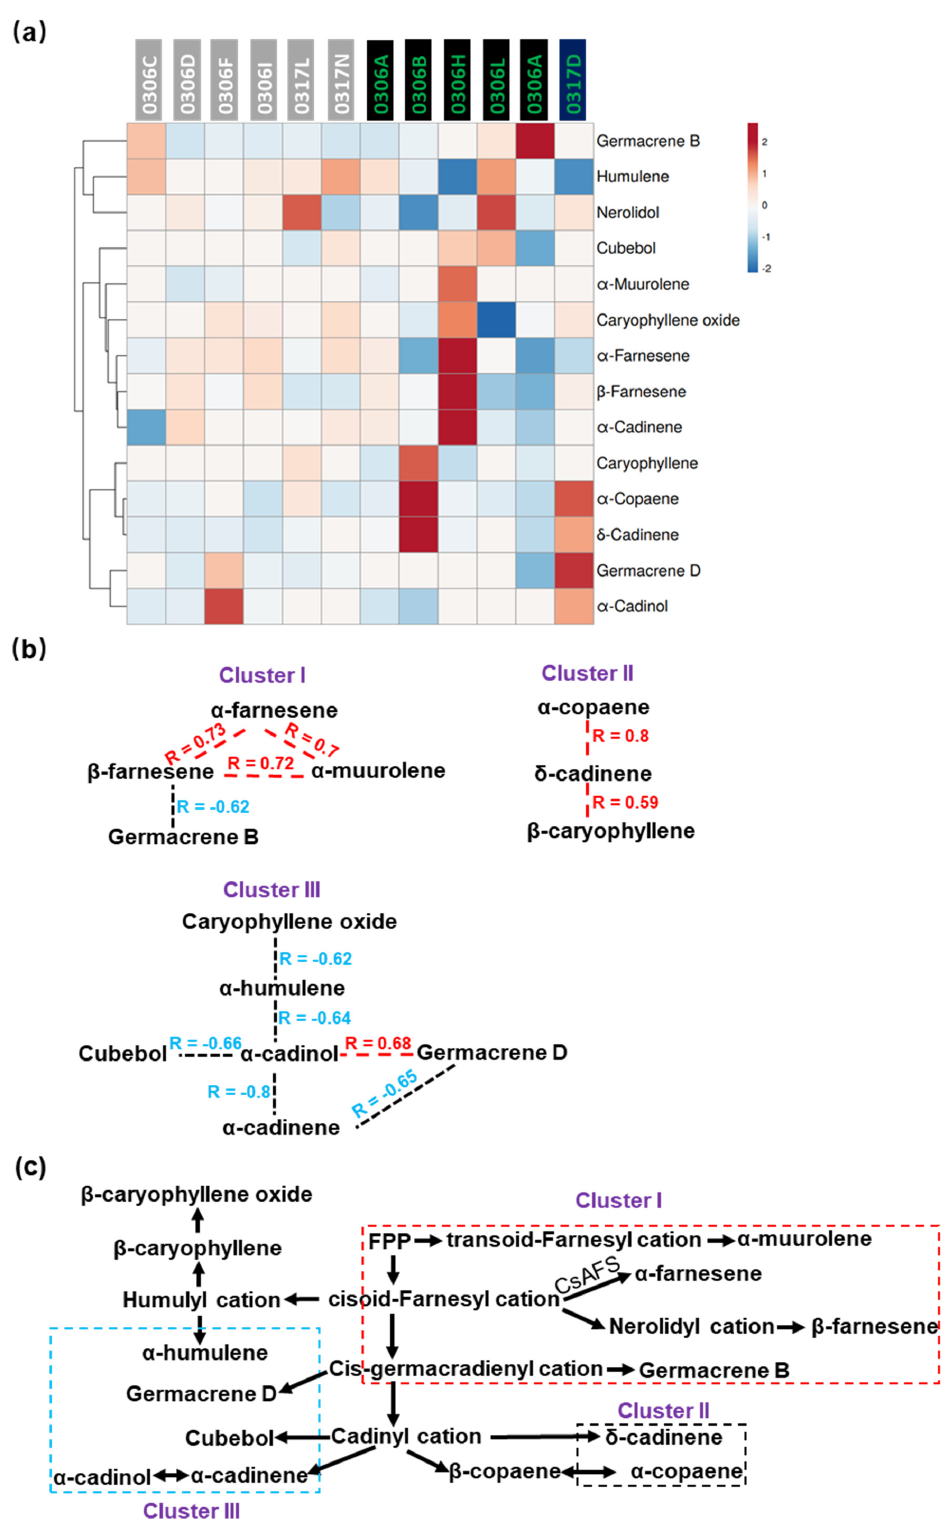
Figure 4. MVA volatile clustering based on correlation types and connectivity. ( a ) HCA and heat map analysis of the volatiles derived from the MVA pathway. ( b ) MVA volatiles were grouped into three clusters based on their correlations and connectivity. The red dashed lines represent a significant positive correlation; the black dashed lines represent a significant negative correlation; ( c ) proposed sesquiterpene volatile synthesis